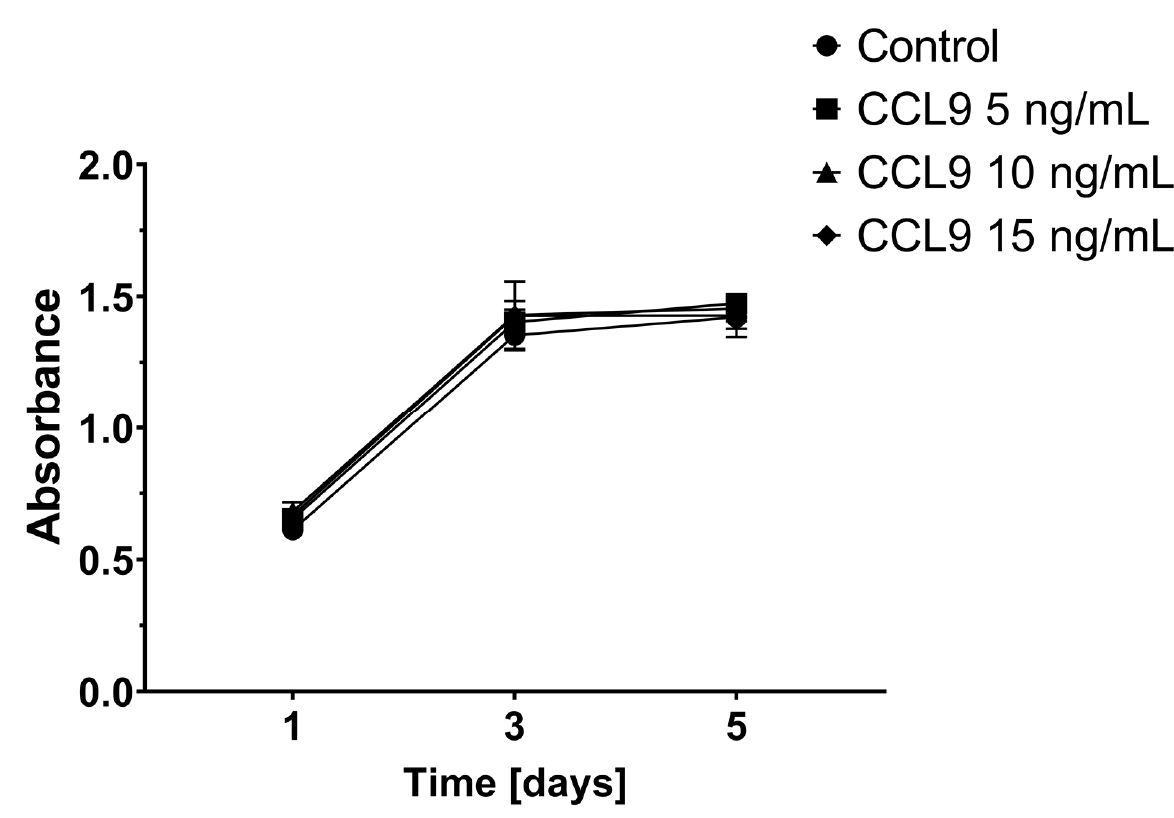
Figure 2. CT26 cell proliferation upon CCL9 addition to the culture medium was evaluated by MTS tests. Each experiment was performed in three